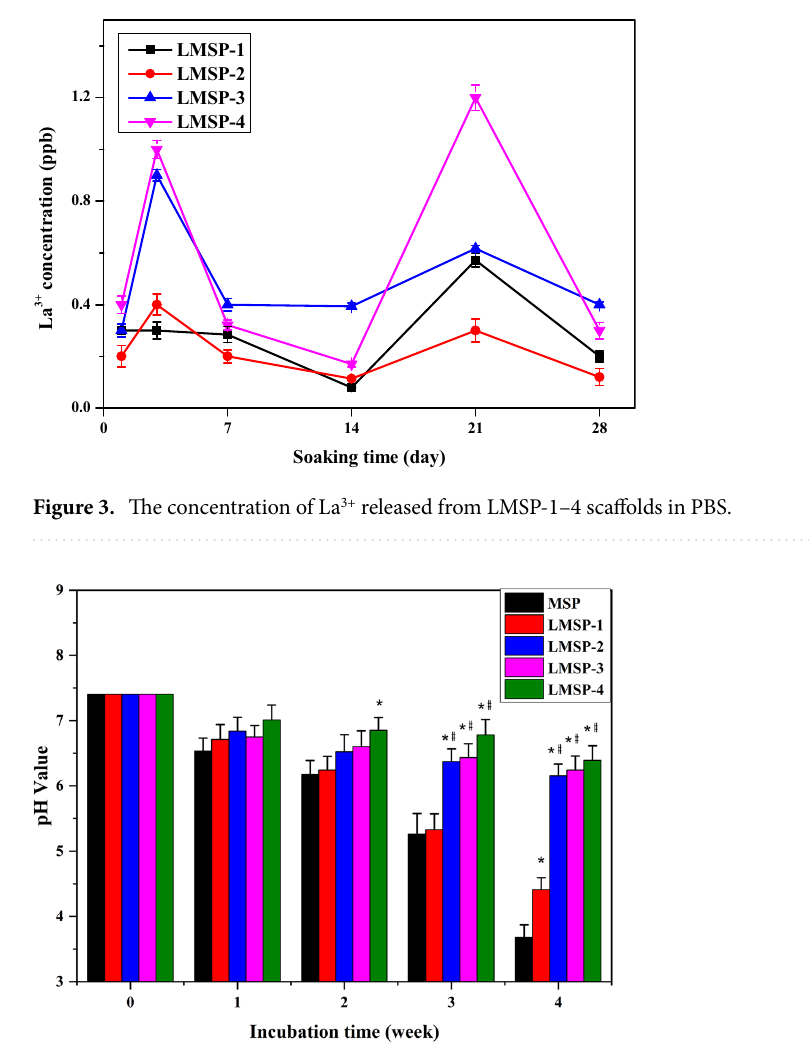
Figure 4. Changes in pH value of PBS during degradation of MSP and LMSP-1–4 scaffolds. (*) and (#) Indicates statistical significance when compared with the MSP and LMSP-1 group, respectively (p <